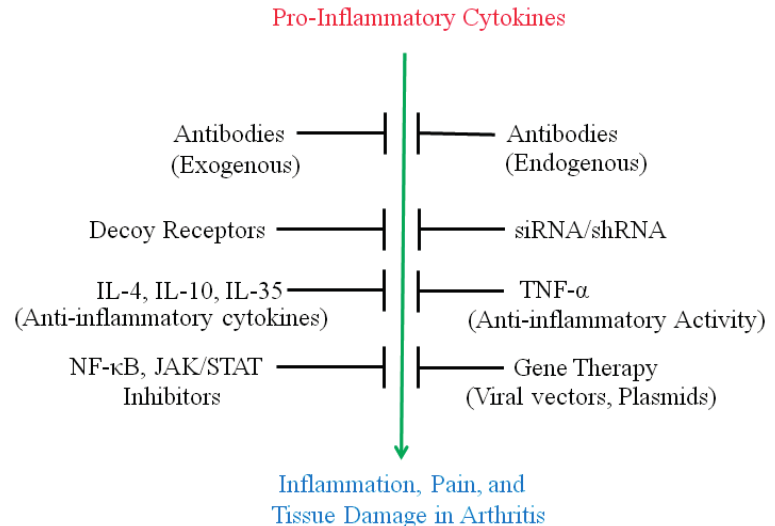
Figure 2. Diverse strategies employed to control the activity of pro-inflammatory cytokines and tissue damage. Pro-inflammatory cytokines, when produced in excess, can cause significant damage to tissues in various autoimmune diseases. Multiple approaches have been developed to prevent and ameliorate the harmful side effects of the pro-inflammatory cytokines. Anti-cytokine antibodies can inhibit the binding of the cytokines to their receptors. Decoy receptors can similarly bind the cytokines and prevent them from binding to the corresponding natural receptors on the cell surface. Gene therapy can be used to suppress the production of specific pro-inflammatory cytokines, whereas siRNAs can silence particular mRNA that encode the cytokine and thereby, prevent its production. Small molecule inhibitors can target certain pathways involved in the production of pro-inflammatory cytokines as well as inhibit their signaling abilities. Finally, anti-inflammatory cytokines help downregulate the pathogenic immune responses and subsequently inhibit further tissue damage. Paradoxically, TNF α can display anti-inflammatory properties under certain